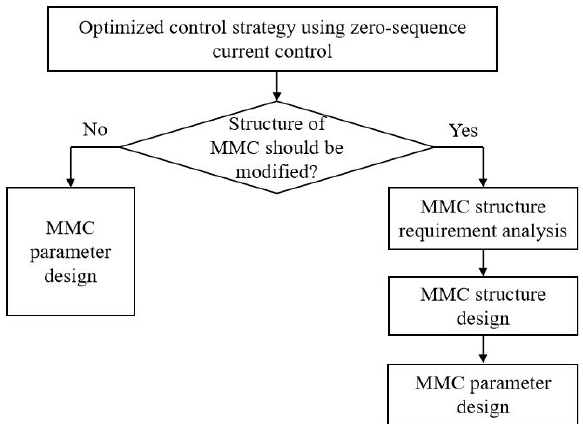
Figure 5. Optimization methodology and